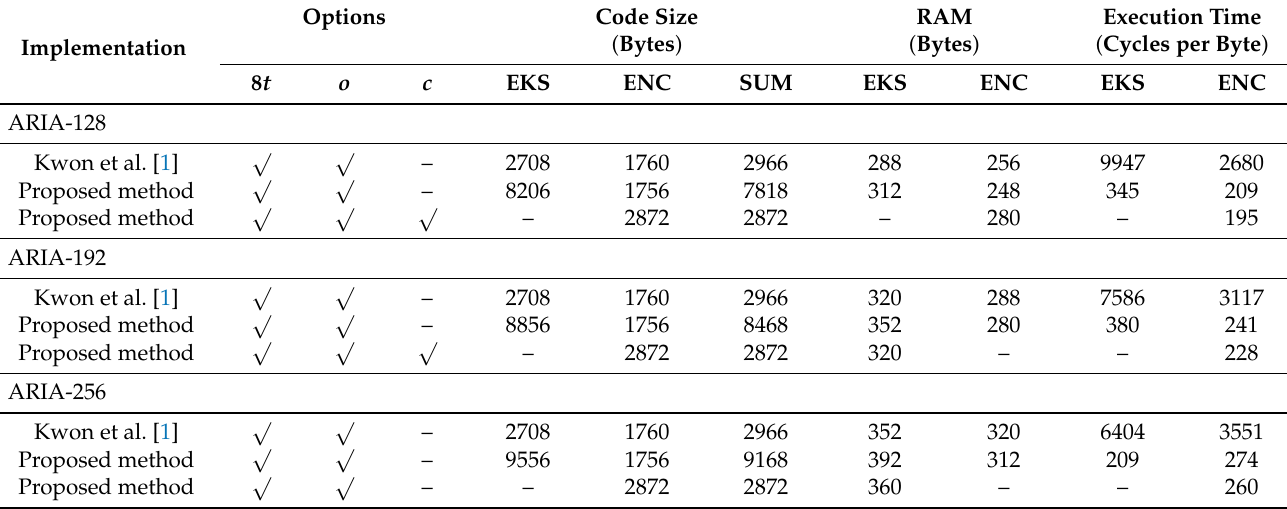
Table 5. Performance evaluation of ARIA on MSP430 in terms of code size (bytes), RAM (bytes), and execution time (clock cycles per byte), where 8 t , o , and c represent 8 × 8 pre-computation-based implementation, pre-computation stored in ROM, and counter mode of operation, respectively. EKS, ENC, and SUM represent encryption key scheduling, encryption, decryption, and summation, respectively.